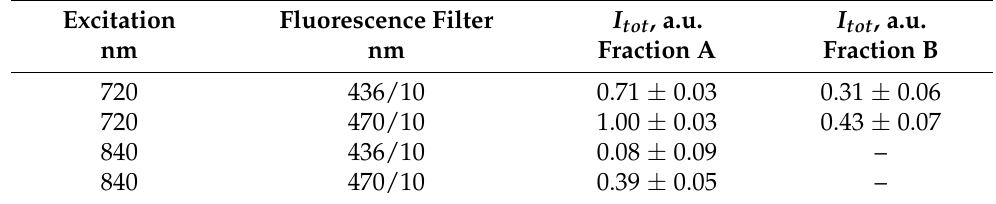
Table 1. Fluorescence intensities in the fractions A and B under excitation at 720 nm and 840 nm recorded within the spectral ranges of 436 ± 10 nm and 470 ± 10